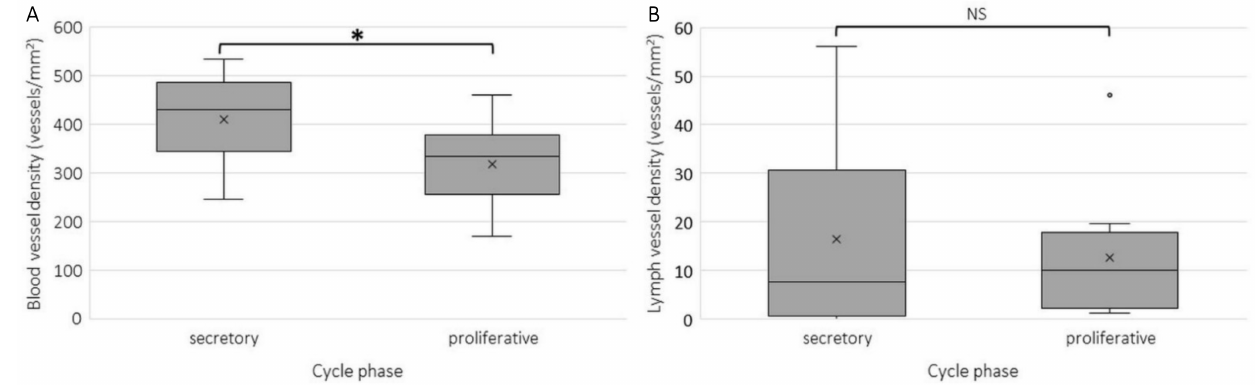
Figure 4. Boxplots of blood vessel density determined by the count of CD31 stained areas (vessels) per mm 2 CD10 stained area ( A ) and lymph vessel density determined by the count of podoplanin stained areas per mm 2 CD10 stained area ( B ) in the eutopic endometrium in the secretory ( n = 20, missing n = 4) and proliferative ( n = 11, missing n = 3) menstrual cycle phase. The blood vessel density was significantly higher in the secretory than in the proliferative cycle phase ( p < 0.05). There was no significant difference in lymph vessel density between the secretory and proliferative cycle phase. Data are shown as median ± range for all patient data pooled. NS: not significant; * significance p < 0.05.